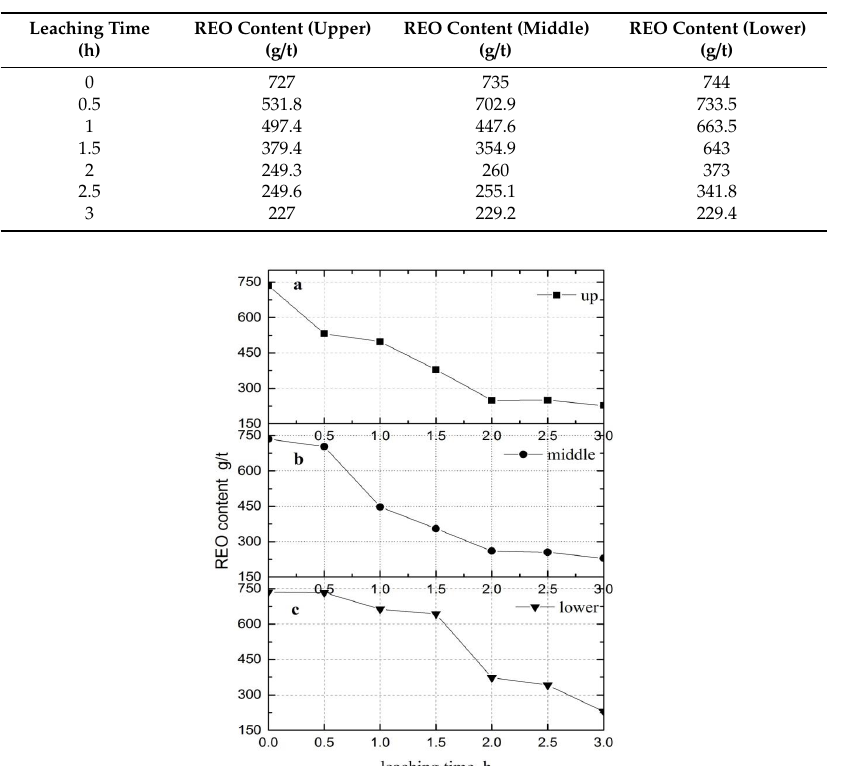
Table 4. REO contents in di ff erent parts of the sample during the (NH 4 ) 2 SO 4 leaching test.